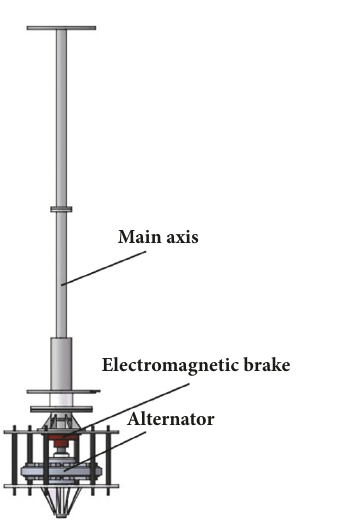
Figure 4: The structure of nacelle.